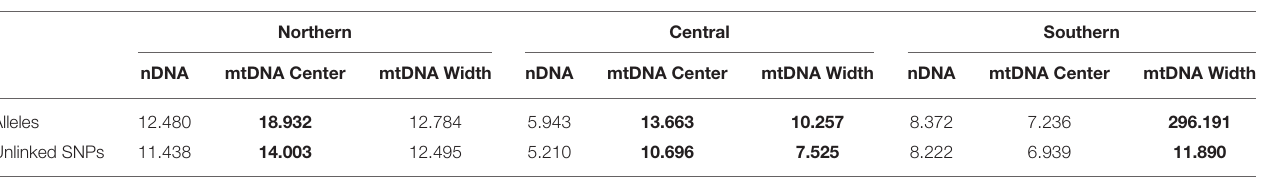
TABLE 2 | AIC scores for genetic clines from Hzar